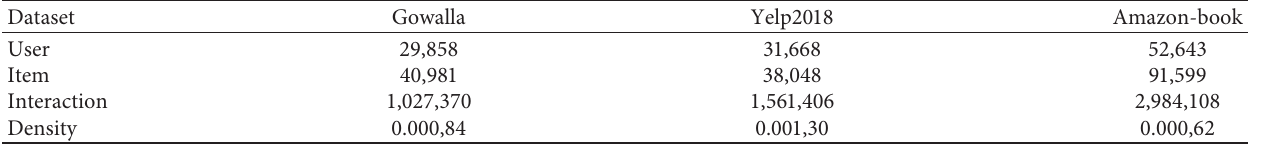
Table 1: Statistics of the tested